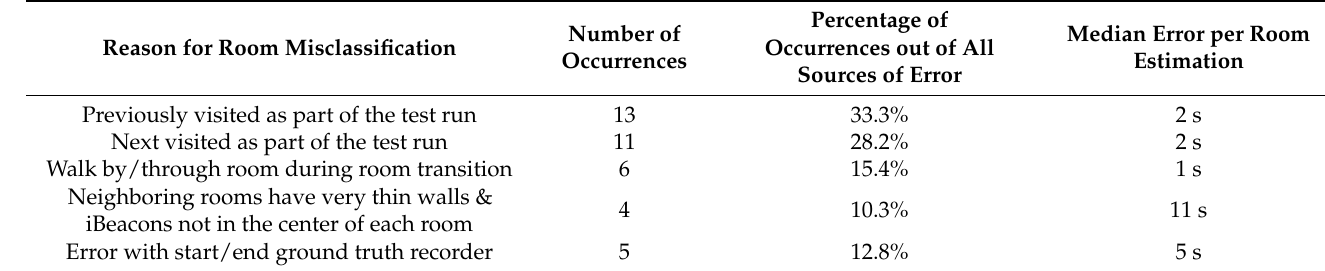
Table 3. Summary of sources of error during the internal study.